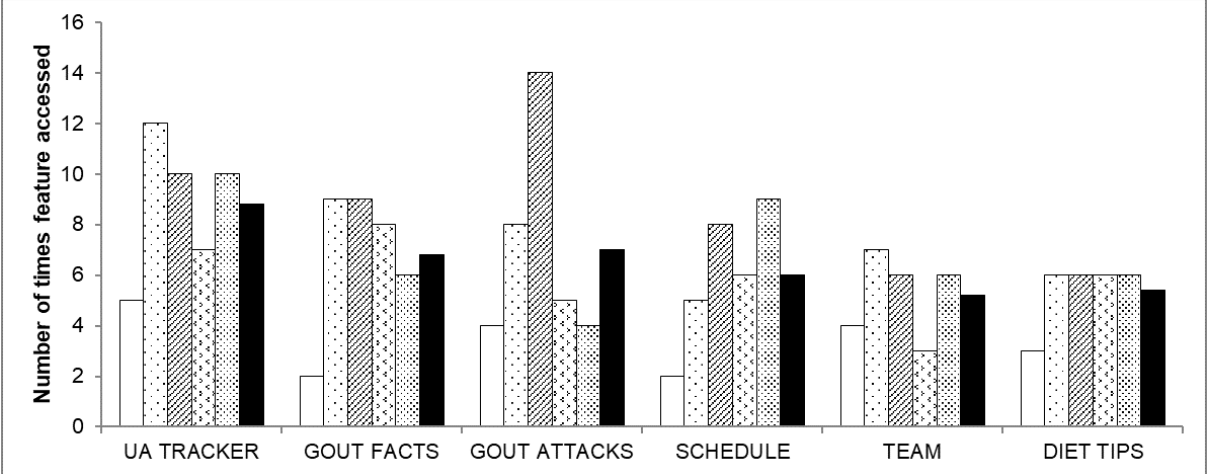
Figure 5. Number of times each feature of Healthy.me Gout was accessed by patients during the 2-week pilot. UA: uric